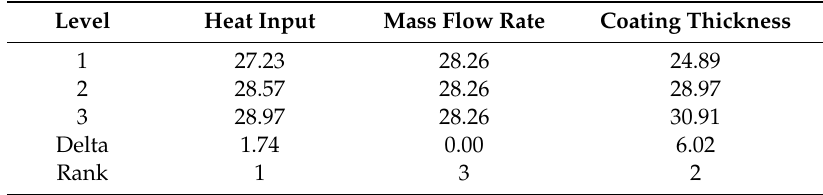
Table 11. Response Table for SNRA.